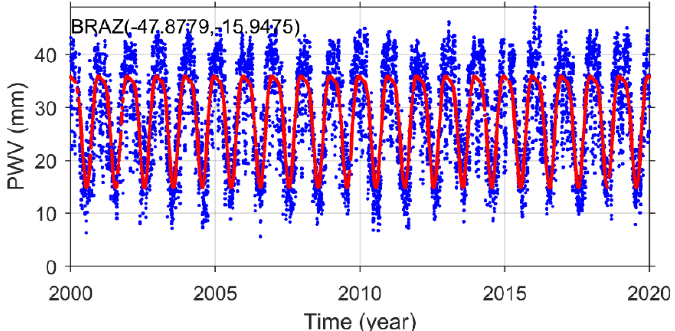
Figure A3. PWV time series (blue dots) and its fitting (red line) from the GNSS station CAGS.